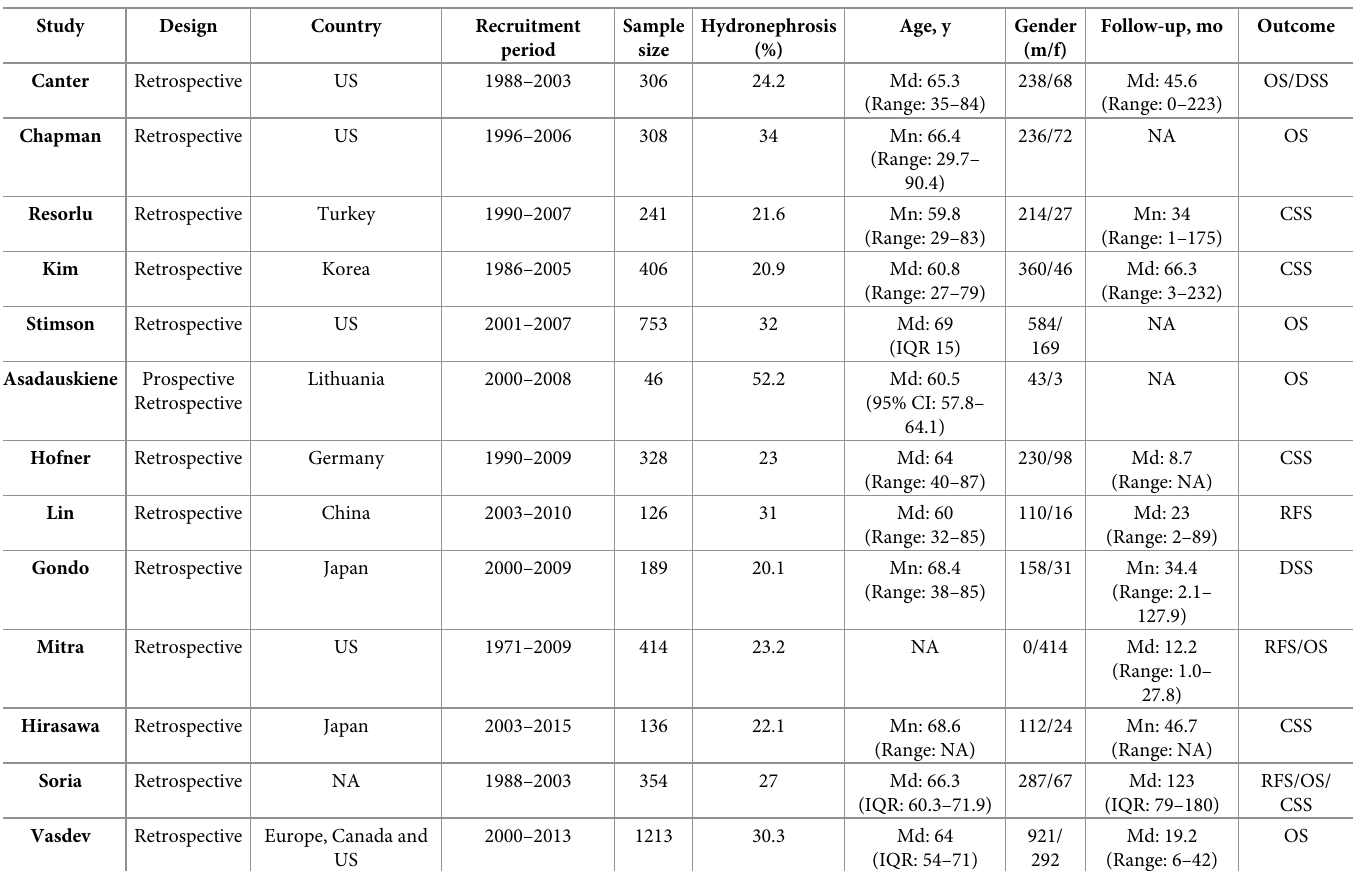
Table 1. Baseline characteristics of the included